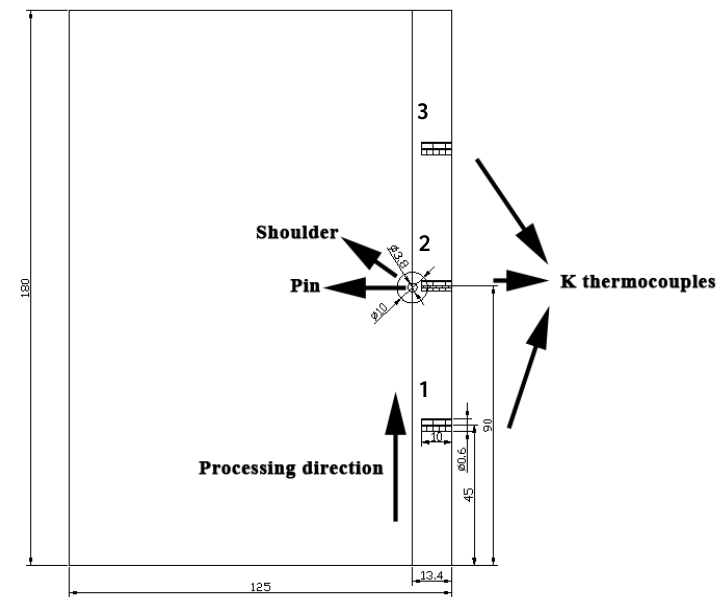
Figure 11. Schematic diagram of positions for measurement of temperature (Unit: